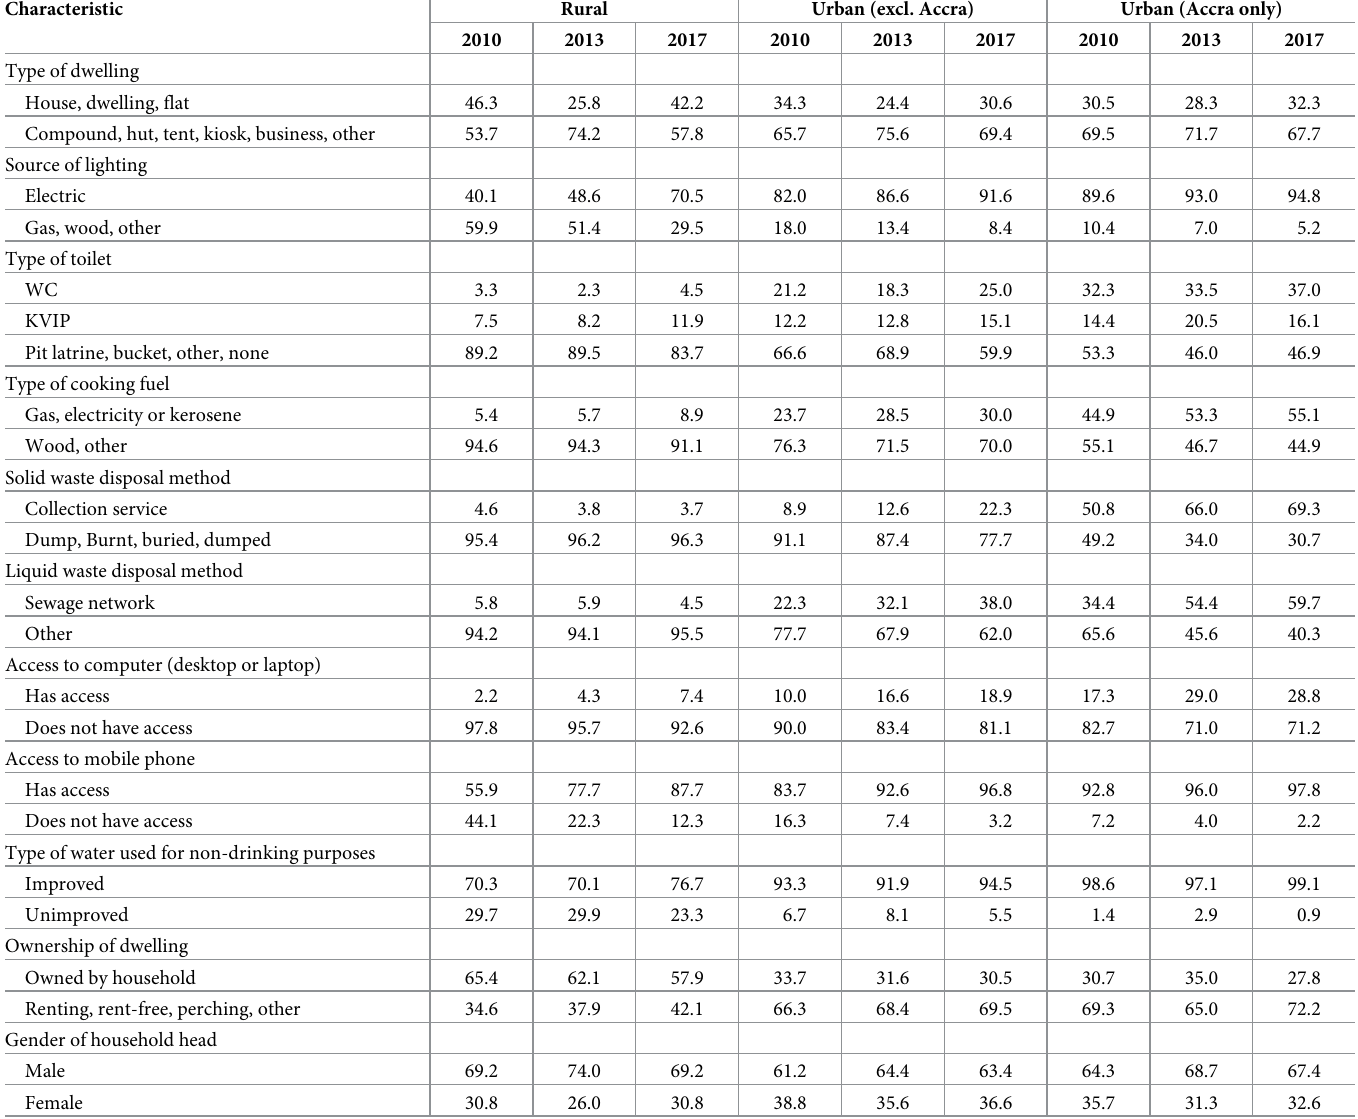
Table 3. Distribution of household characteristics in 2010, 2013 and